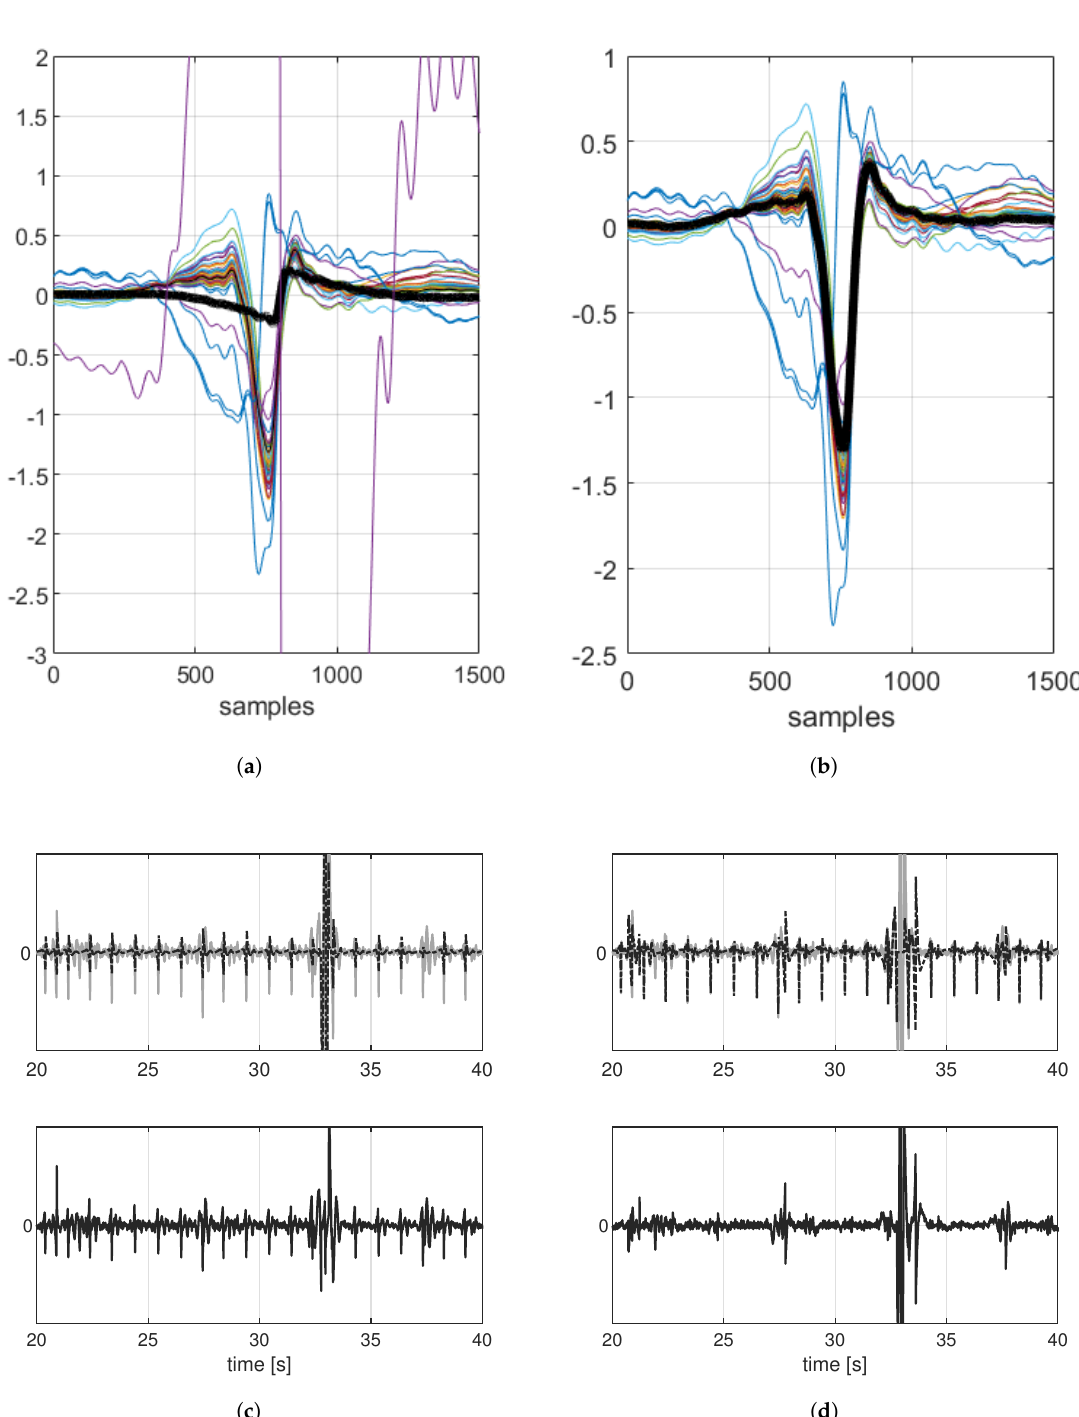
Figure 8. ( a , b )Aligned segments employed for SVD decomposition and the related obtained template (black). ( a ) Approx- imation of the cardiac cycle is wrong due to the presence of high artifacts. ( b ) The estimation is correct by discarding the segments with artifacts. ( c , d ) Comparison between the independent components obtained by ICA (grey), the mECG estimated (black dash-dot) and the resulting signals after the canceling (black). ( c ) Canceling with VA, part of the mECG is not correctly removed. ( d ) Employing the proposed approach, the mECG is effectively